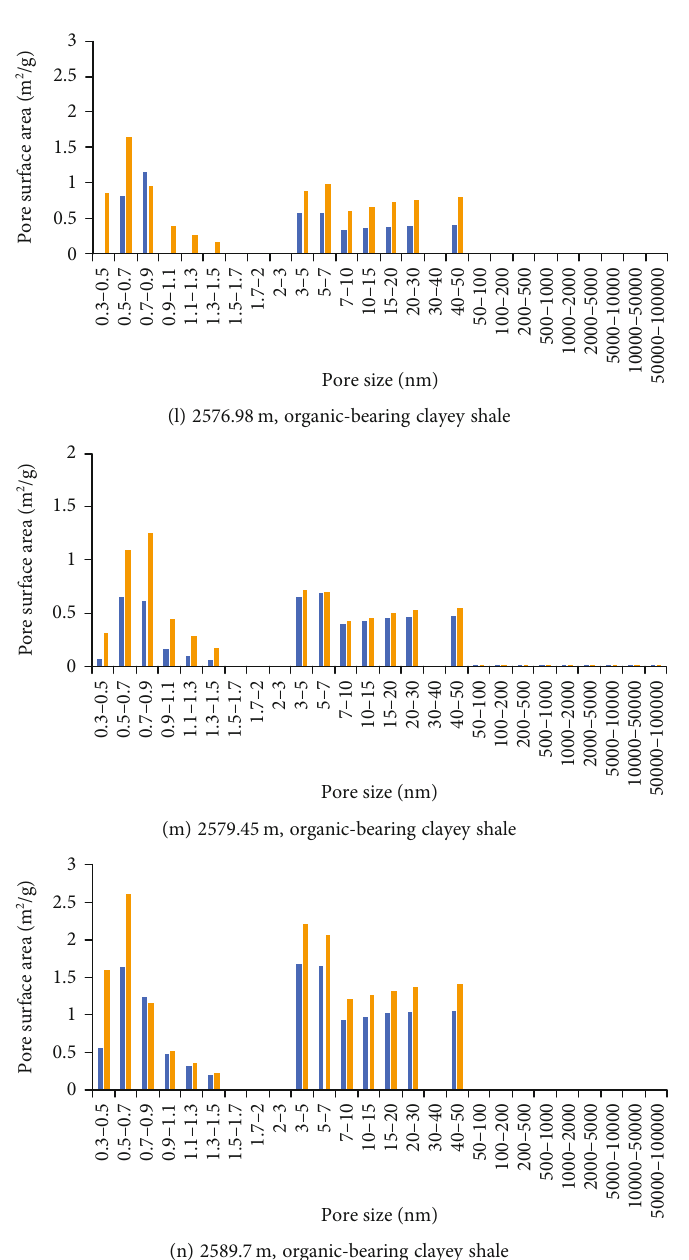
Figure 5: Pore surface area features based on the joint characterization for full-scale pore size of di ff erent shale samples in TY1 well. Blue: pore surface area data of shale samples before the extraction of shale oil; Yellow: pore surface area data of shale samples after the extraction of shale